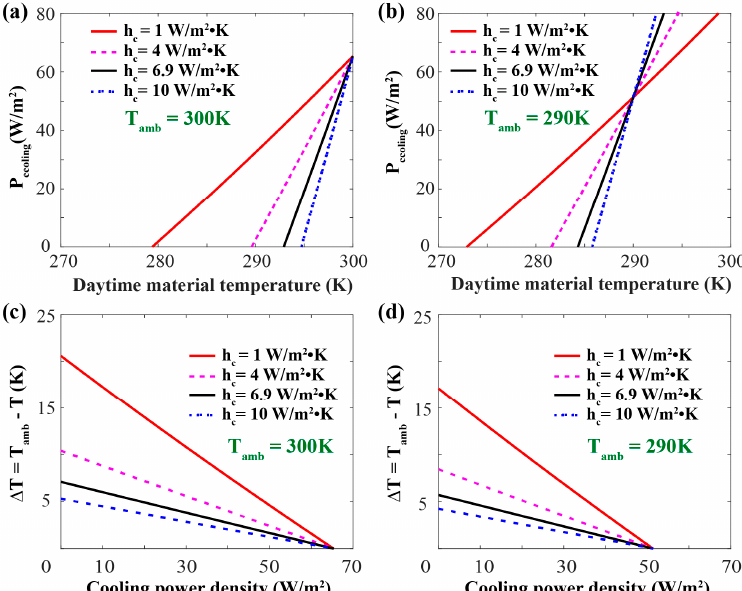
coating demonstrated in Figure 2.